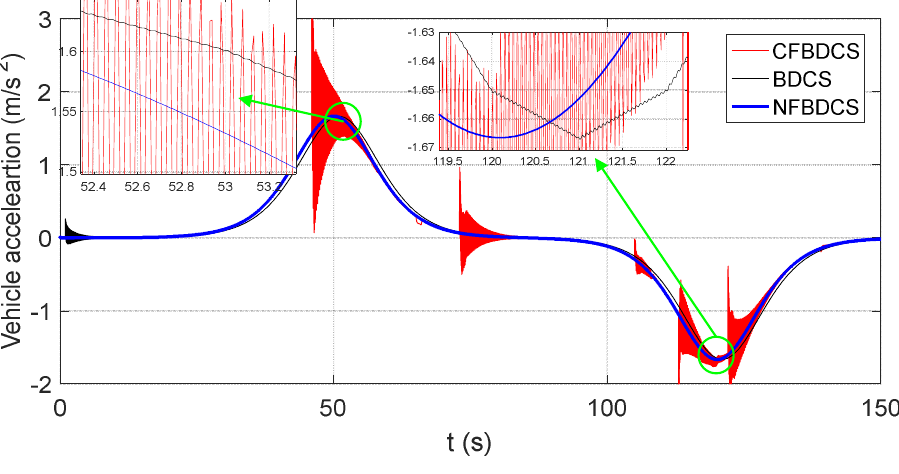
Figure 21. Vehicle acceleration with Δ t = 1 s.